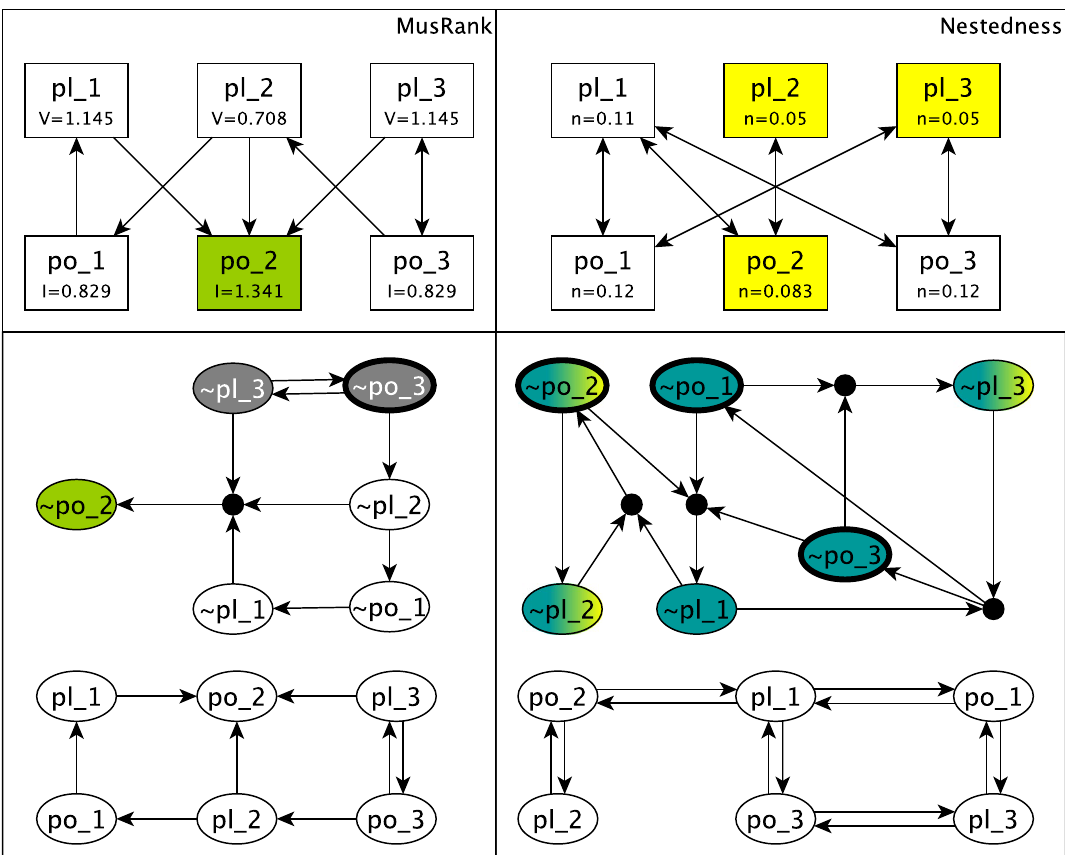
Figure 8. Networks illustrating examples of when structural measures fail to identify keystone species. In both columns simplified networks consisting of 3 plant and 3 pollinator species are presented. The MusRank is calculated for all the nodes in the network in the left column and denoted in the node labels. The expanded network corresponding to this network is shown below. Node contribution to network nestedness is calculated for all the nodes in the network in the right column and denoted in the node labels. Similarly the expanded network that correspond to it is shown below. Note that these two networks have different edges. In the left column MusRank score identifies node po_2, highlighted with green, as the most important, while the expanded network shows that the extinction of po_2 does not cause any further damage to the community, as this node has no outgoing edges. This is due to the fact that MusRank calculation process fails to consider the directed network and replaces all the directed edges with undirected ones. The MusRank score does not identify po_3 as a crucial species; however, virtual node ∼ po_3, outlined with black in the expanded network is a driver of a stable motif that has all other nodes in its LDOI; the extinction of po_3 leads to full community collapse. In the right column, the nodes highlighted with yellow (pl_2, pl_3, and po_2) have the lowest node contribution to nestedness, which predicts that these nodes are likely crucial to the stability of the community. Analyzing the expanded network, one can see that these three nodes together are not able to drive the inactive stable motif highlighted with teal. The minimal driver set for this stable motif, outlined with black, consists of { ∼ po_1, ∼ po_2, ∼ po_3}; together these nodes drive the inactive stable motif and cause full community collapse. The nestedness-based measure was not able to capture the significance of nodes po2 and